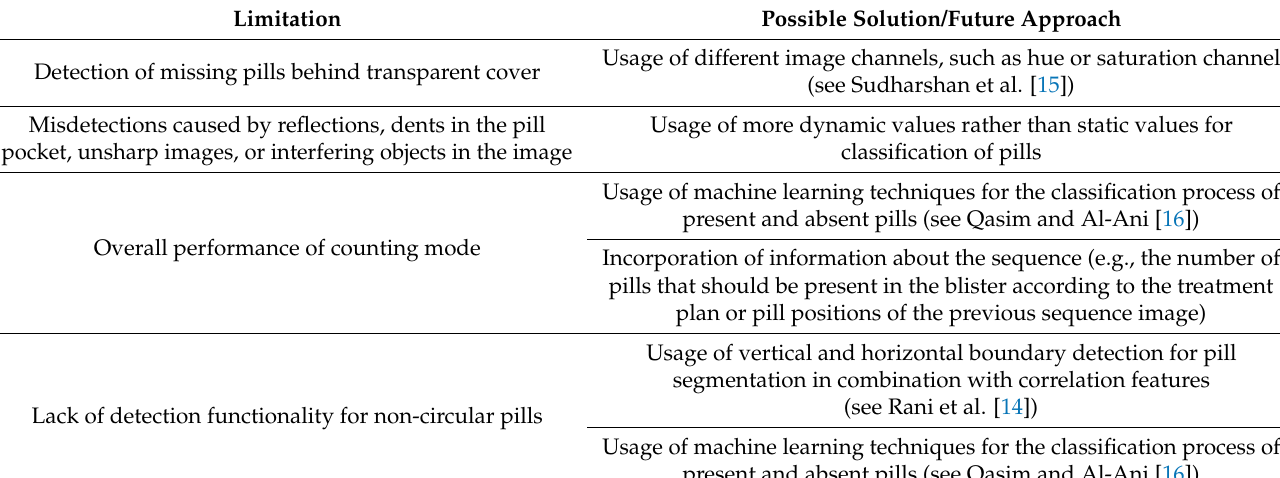
Table 4. Summary of limitations and possible solutions in a future